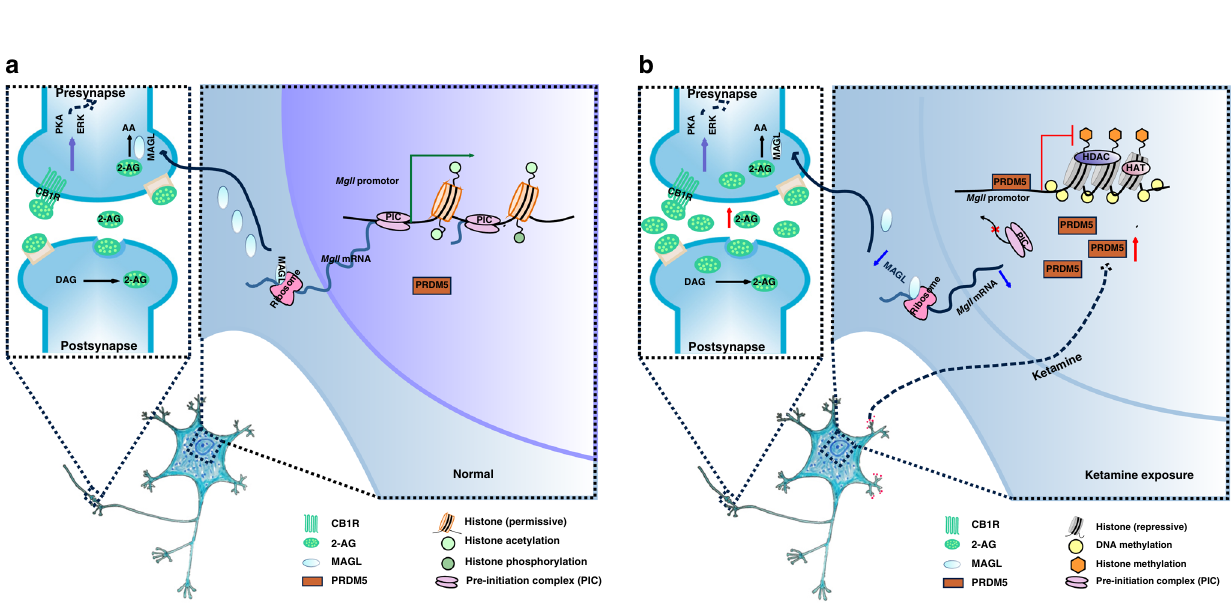
Fig. 8 PRDM5-MAGL-2-AG-CB1R pathway in the DLS regulates ketamine addiction. a Simpli fi ed scheme of PRDM5-MAGL-2-AG-CB1R pathway in normal mice. b Simpli fi ed scheme of PRDM5-MAGL-2-AG-CB1R pathway in mice under ketamine conditioning paradigm. Ketamine represses Mgll gene transcription by enhancing the binding of PRDM5 at the promoter of gene Mgll , leading to the decreased MGL expression and 2-AG